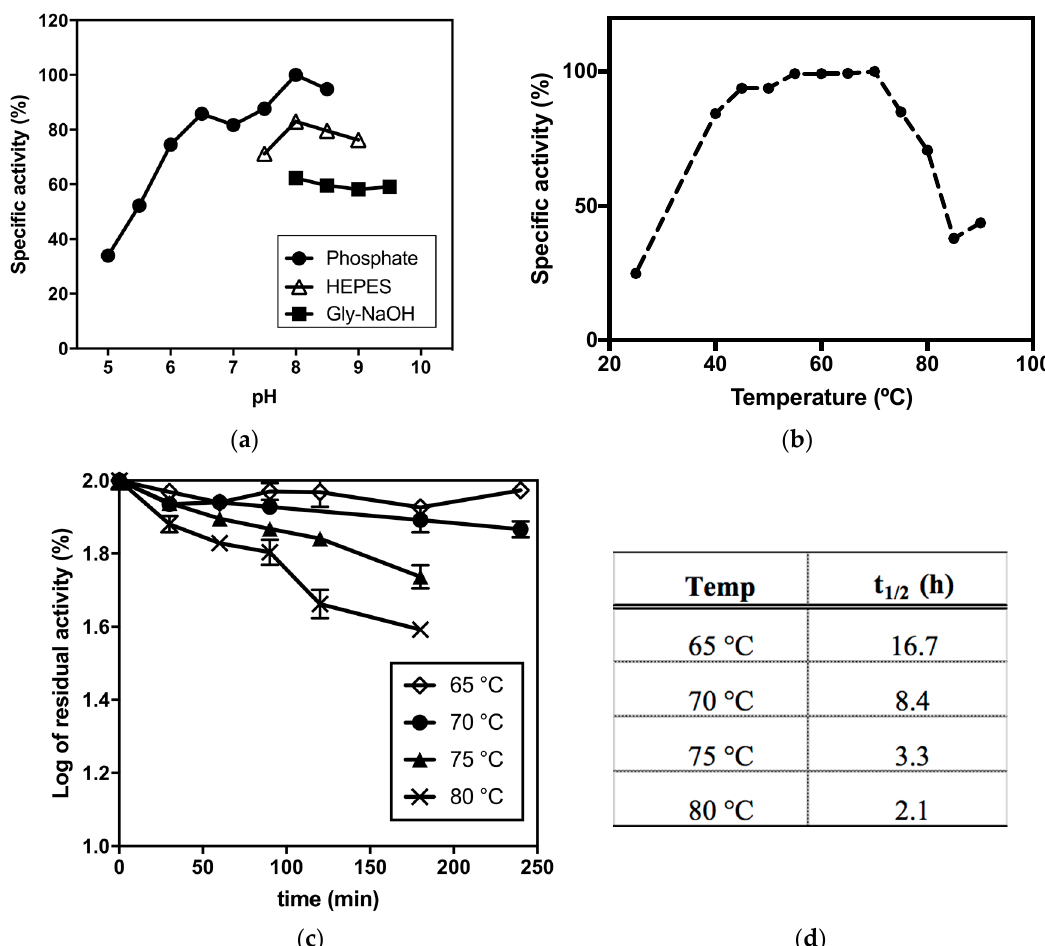
Figure 3. ( a ) pH dependency of paraoxonase activity of 4Mut. Paraoxonase activity of 4Mut was measured at different pH values ranging from 5.0 to 9.5 by using phosphate buffer (pH 5.0–8.5), HEPES-NaOH (pH 7.5–9.0) and Gly-NaOH (pH8.0–9.5). ( b ) Thermophilicity curve of paraoxonase activity of 4Mut. ( c ) Thermal stability of 4Mut. The enzyme (1 mg/mL) in 20 mM HEPES pH 8.5, 0.5 mM CoCl 2 , 200 mM NaCl was incubated at either 65 ◦ C (squares), 70 ◦ C (full circles), 75 ◦ C (full triangles), or 80 ◦ C (cross). Samples were withdrawn at indicated times and analyzed by standard assay at 70 ◦ C. Logarithm of residual activity (%) was calculated against a non-incubated sample. Half lives (t 1 / 2 ) at each temperature are shown in ( d ).